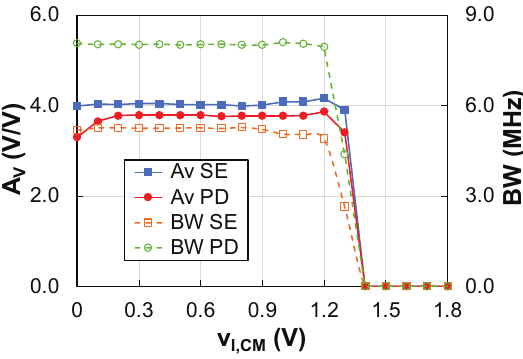
Figure 9. Measured A v and BW vs. v I , CM